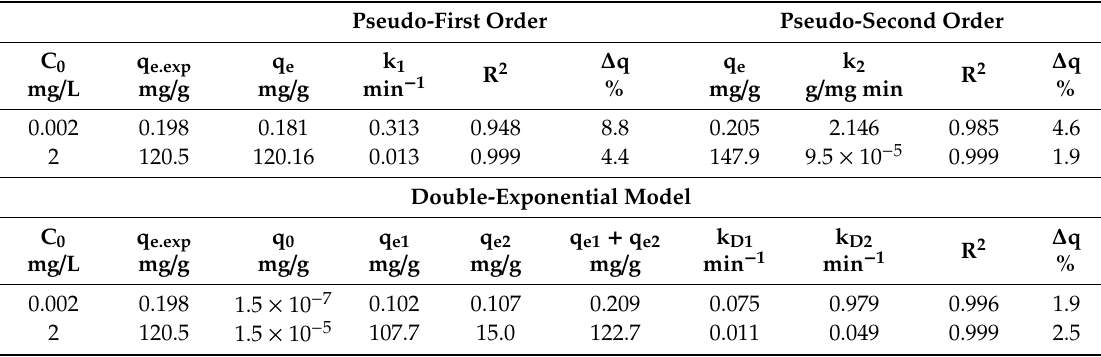
Table 4. SMX adsorption kinetic parameters given for the three kinetic models.